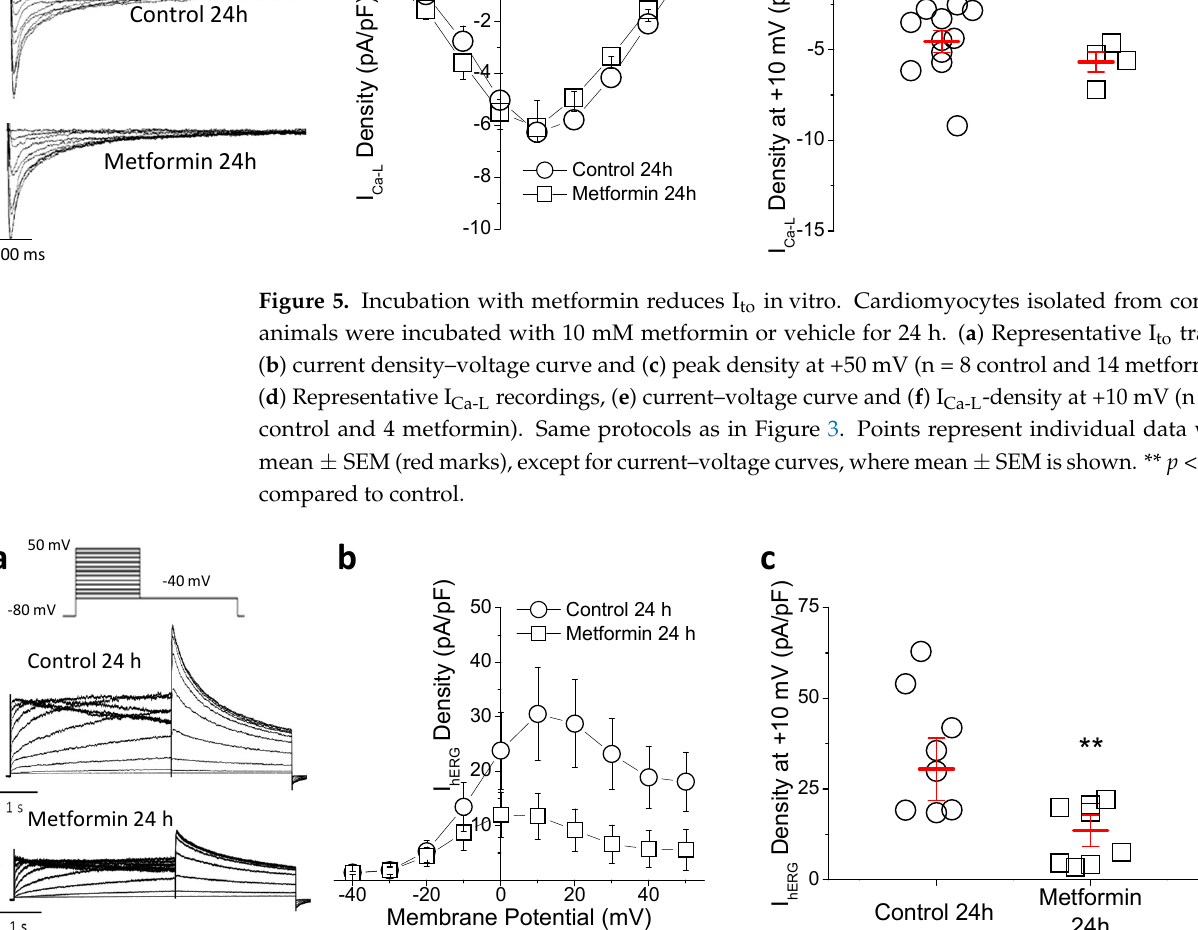
Figure 6. Metformin reduces I hERG . ( a ) Representative I hERG traces recorded in HEK-hERG cells incubated with vehicle or 10 mM metformin for 24 h. ( b ) Mean current density–voltage relation and ( c ) peak-density values at +10 mV (n = 8 control and 9 metformin). Points represent individual data with mean ± SEM except, for the current-voltage curve, where mean ± SEM (red marks) is shown. ** p < 0.01 compared to